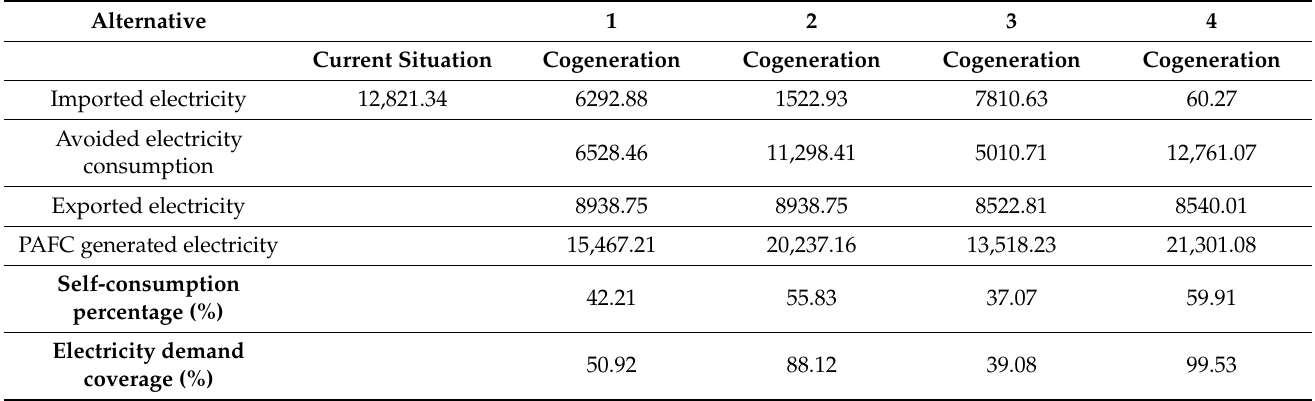
Table A2. Electrical Energy Balance (MWh/year) for alternatives considering 4 MW fuel cell power.